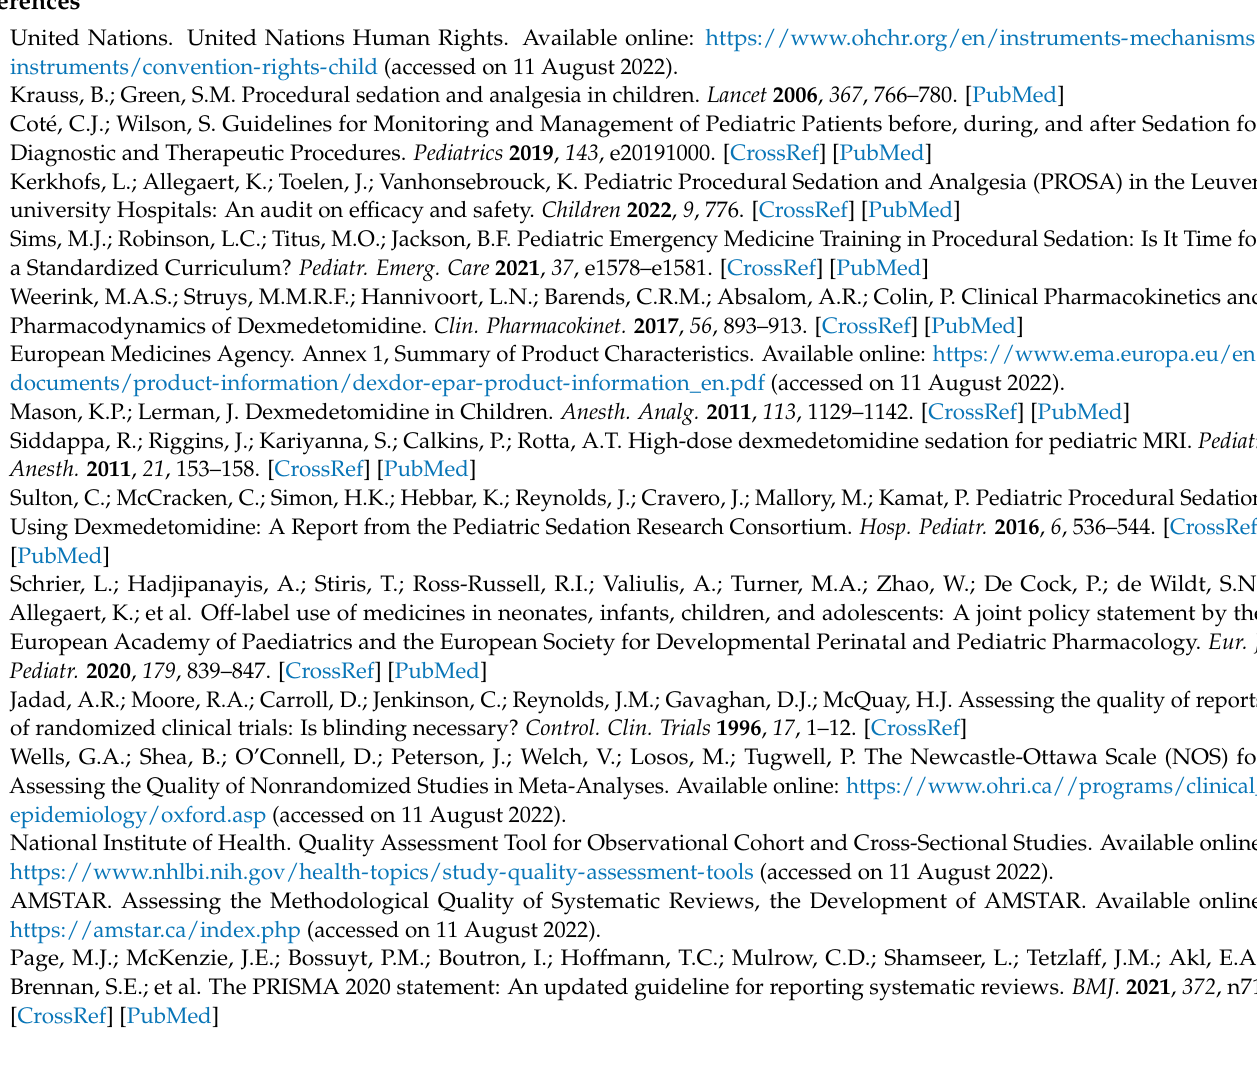
the Jadad scale, Table S2: Overview assessment on the Newcastle–Ottawa scale, Table S3: Overview assessments based on the National Institute of Health (NIH) Quality Assessment Tool, Table S4: Overview assessment based on AMSTAR 2, Table S5: Data extraction of the eight studies retained in the systematic review, reporting on purpose and outcomes, study design and characteristics, type of imaging and sample size, inclusion and exclusion criteria, administration method, timing and dose and outcome variables, including assessment